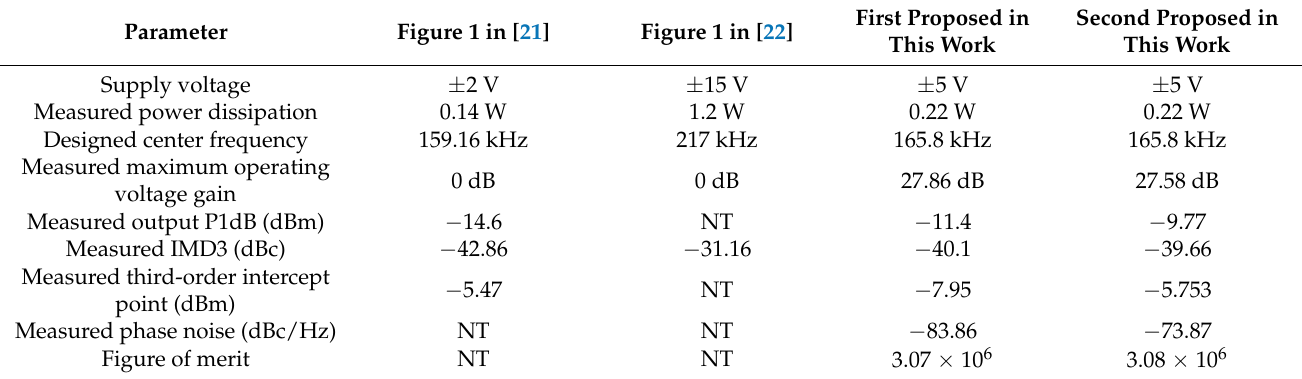
Table 2. The additional performance comparisons with previous VM filters.